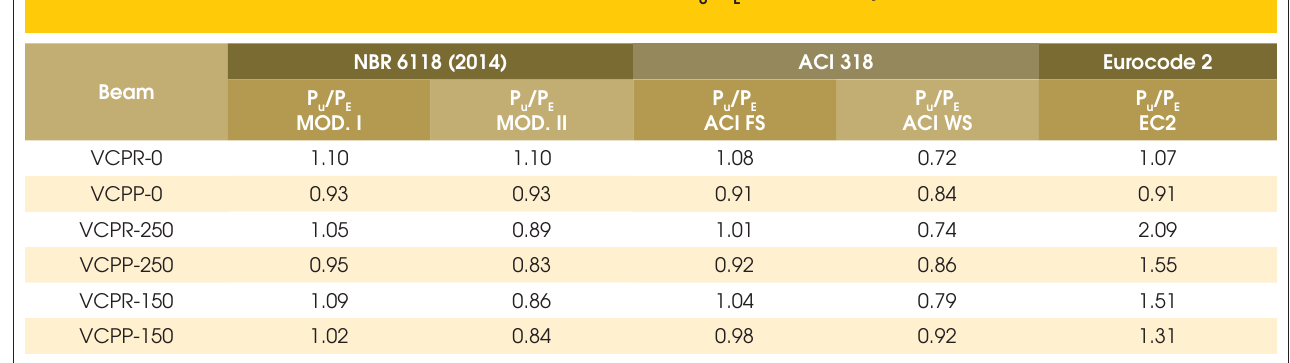
Table 10 – Variation of P